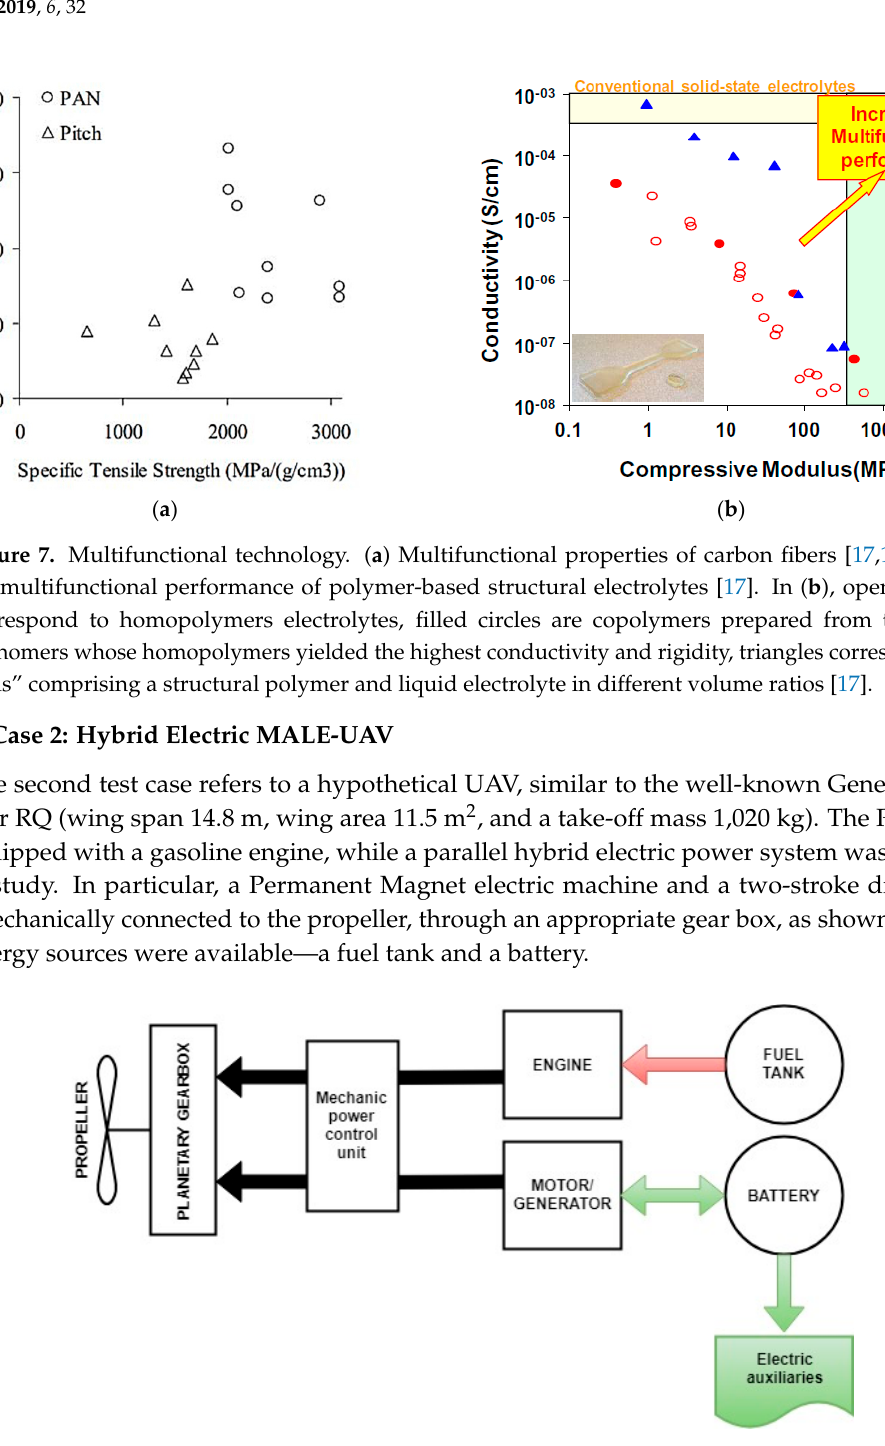
Table 4. Design variables defining the size and technology of the powertrain. Parameters